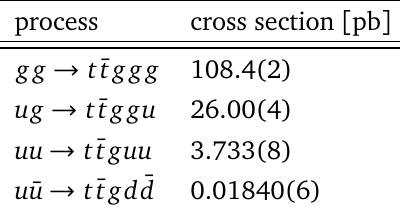
Table 5: Selection of partonic channels contributing to t ¯ t + 3 jets production at the LHC and their corresponding leading-order production cross sections.